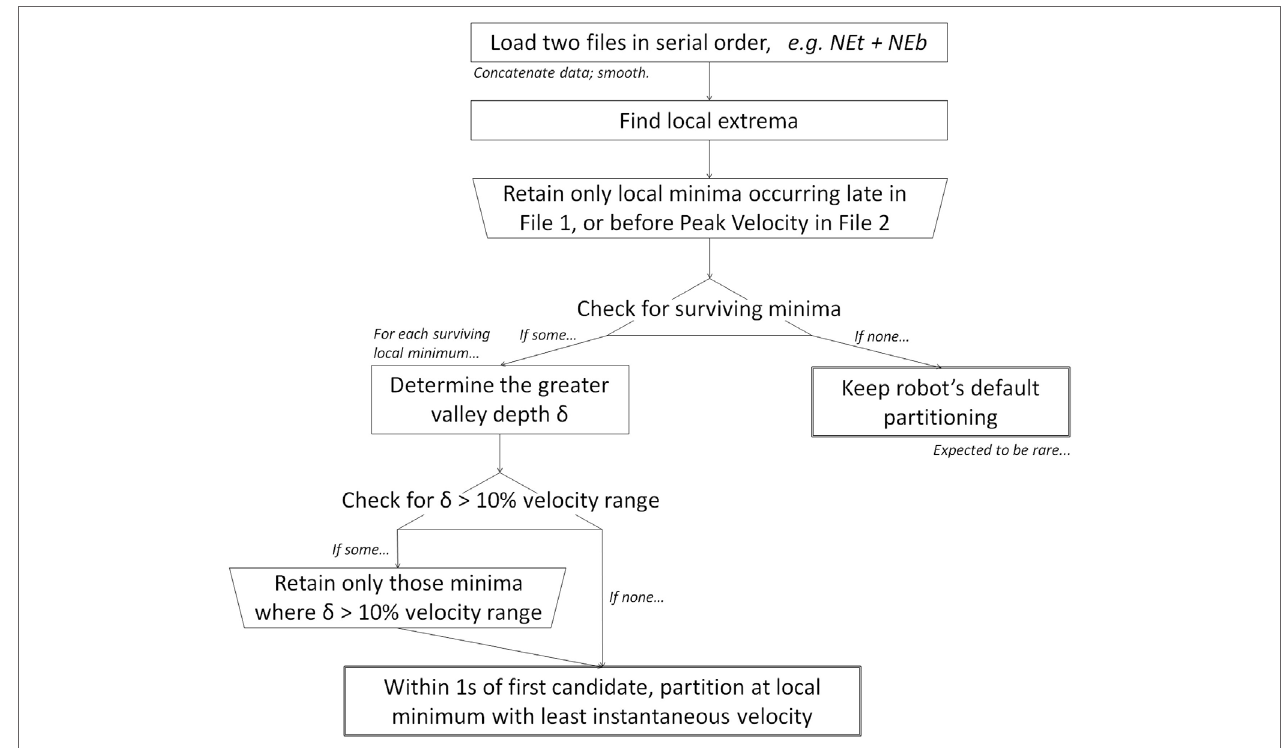
FiguRe 3 | Flowchart summarizing partitioning